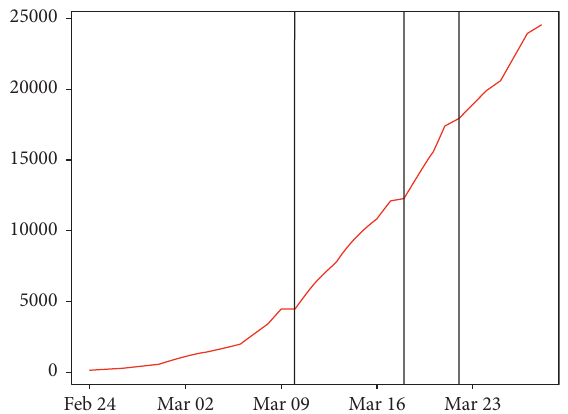
Figure 1: Number of people tested positive (Lombardia) (original data).